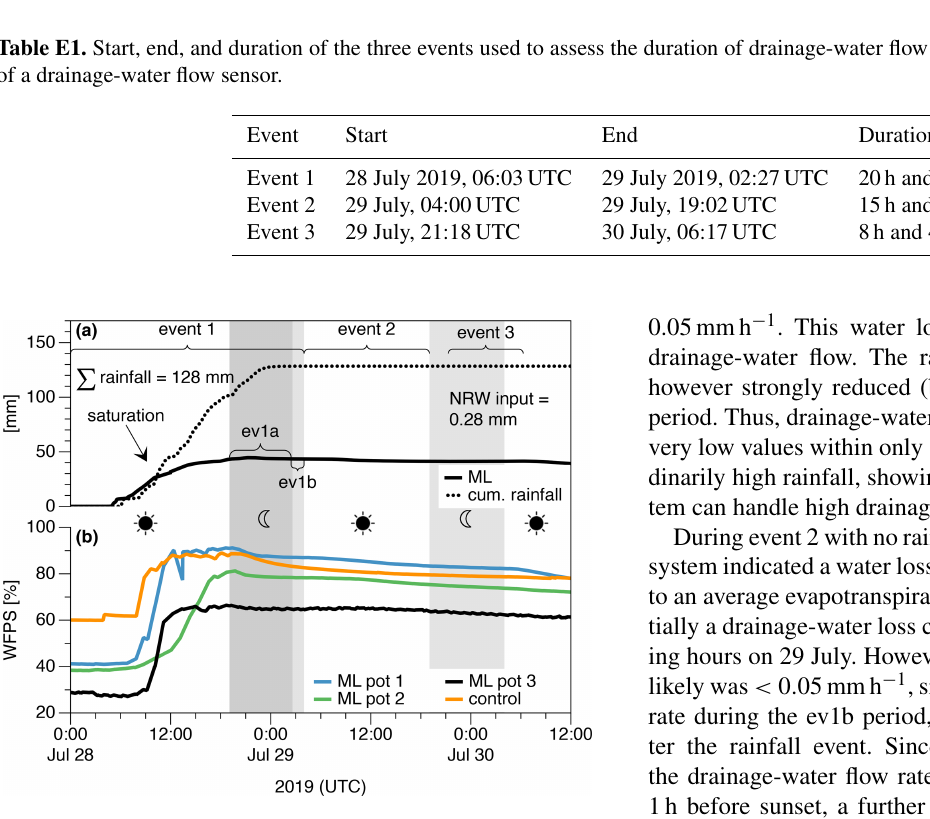
Figure E1. (a) Cumulative rainfall and ML mass during a rainfall (event 1), an evapotranspiration (event 2), and a NRW (event 3) event, from 28 July, 00:00, till 30 July, 12:00UTC. The grey-shaded areas indicate night-time duration (sunset till sunrise), the unshaded areas day-time duration (sunrise till sunset). The ML mass and the cumulative rainfall increased at the same rate until the ML pots were almost saturated (indicated with an arrow). Afterwards there was more drainage water lost from the ML pots than water gained. Dur- ing the ev1a period (from sunset till the end of rainfall in event1), a rainfall water input of 26.9mm was observed, but the ML sys- tem showed a water gain of only 0.3mm, and the difference be- tween the two measurements corresponds to the (unmeasured) loss via drainage-water flow. During the ev1b period (from the end of rainfall till sunrise in event1), there was no rainfall water input, but the ML system showed a water loss of 0.07mm. During event 2 there was a water loss by evapotranspiration of 2.25mm. During event 3 (the following night), there was no water loss but instead a water gain by NRW input of 0.28mm. (b) WFPS inside the ML pots and the control, measured at a depth of 15cm. WFPS reached high values after the rainfall